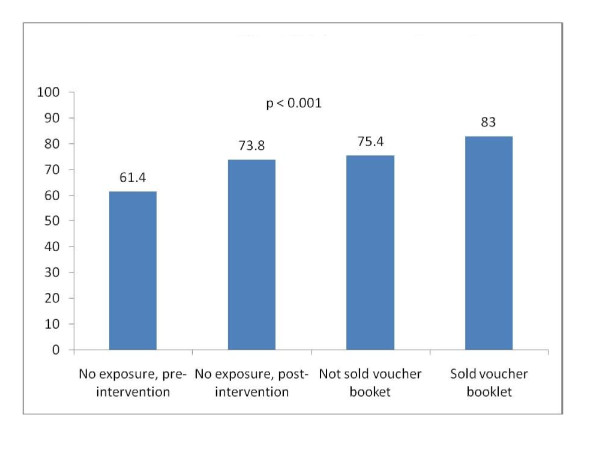
Use of ANC (3+ visits), by exposure to voucher intervention (n = 1,423).